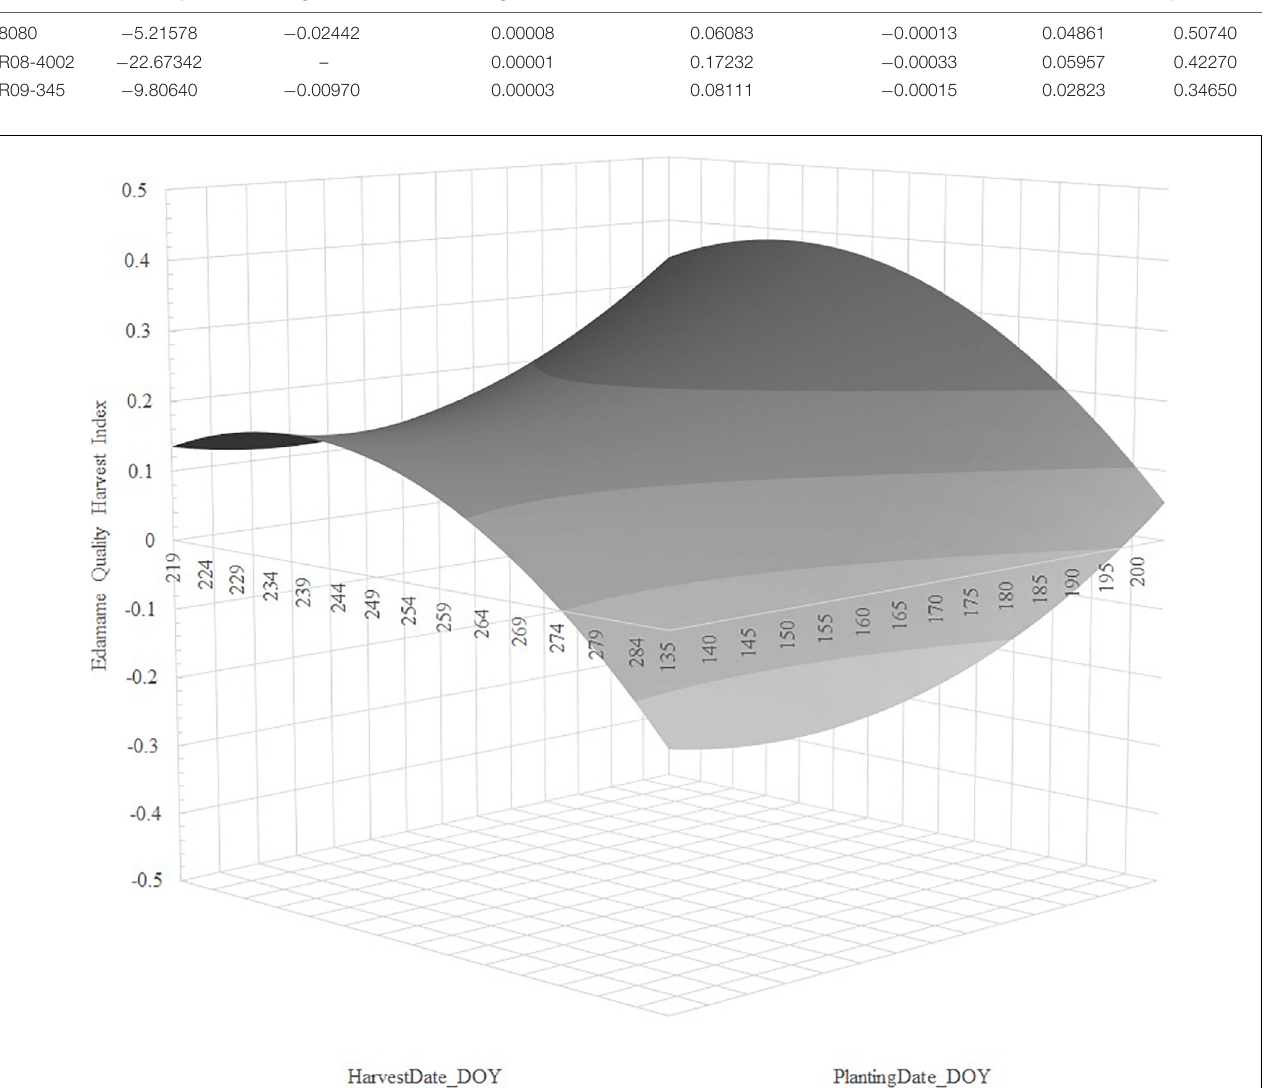
TABLE 1 | Stepwise regression coefficients of cultivar response to Edamame Harvest Quality Index ( EHQI ) based on planting date, harvest date, and their squared values for three edamame cultivars subjected to three planting dates and up to eight harvest dates between stages R5.8 and R7 planted in two Arkansas locations over 2 years. Cultivar